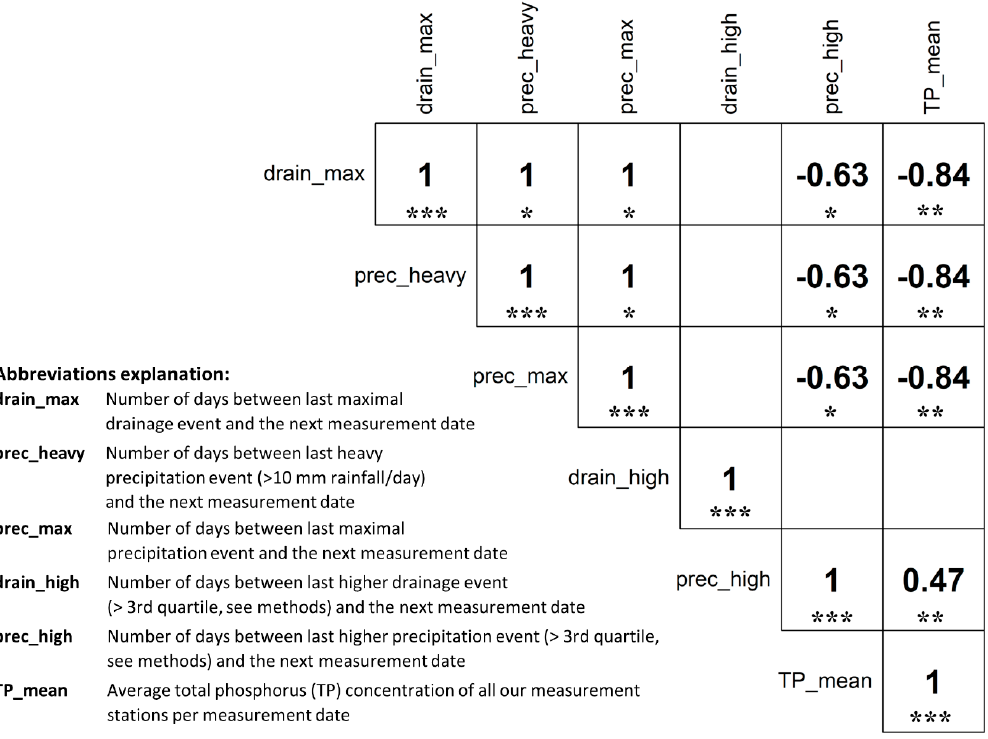
Figure 8. Spearman correlation coefficients of TP concentrations in the water and the number of days between each precipitation event and the next sampling date. (Significance levels: p ≤ 0.001 (***); p ≤ 0.01 (**); p ≤ 0.05 (*)).